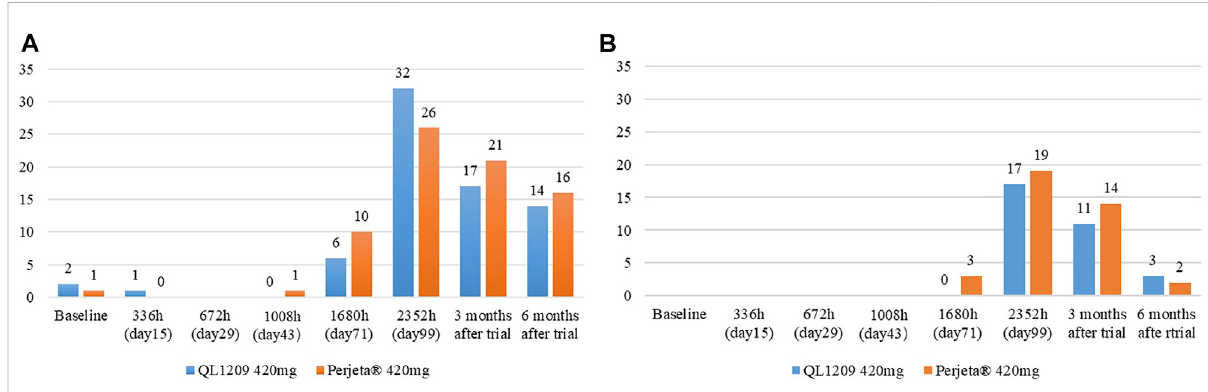
FIGURE 3 (A) The number of ADA-Positive subjects for QL1209 and Perjeta ® at baseline, 336 h (day 15), 672 h (day 29), 1008 h (day 43), 1680 h (day 71), 2352 h(day99),3 monthsaftertrailand6 monthsaftertrail. (B) ThenumberofNab-PositivesubjectsforQL1209andPerjeta ® atbaseline,336 h(day